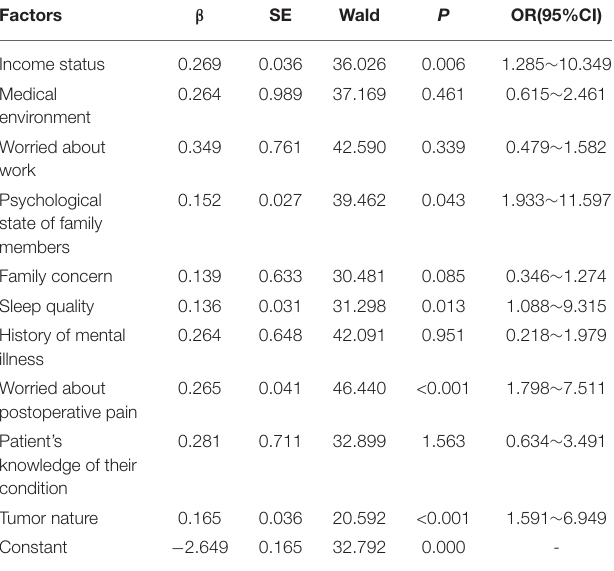
TABLE 3 | Multivariate logistic regression analysis of of psychological status of patients with pulmonary tumor during perioperative